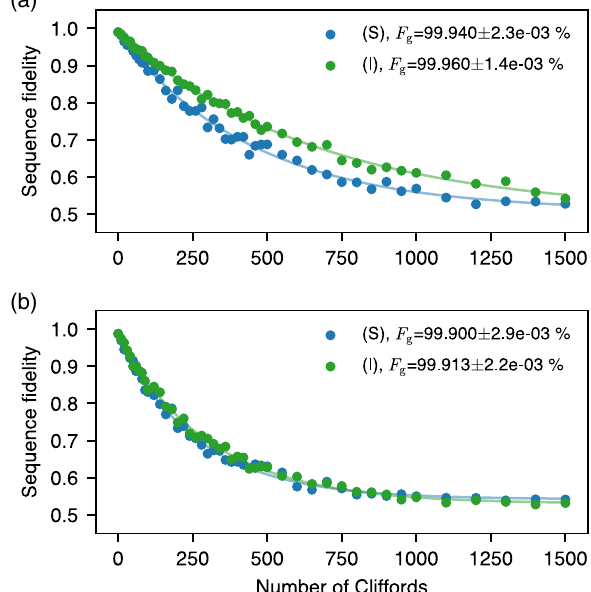
FIG. 23. Experimental results of single-qubit randomized benchmarking, when QB1 and QB2 are detuned by 150 MHz. (a) Single-qubit RB measurement data for QB1. (b) Single-qubit RB measurement data for QB2. “ S ” denotes the simultaneous application of single-qubit Cliffords, and “ I ” denotes the isolated application of single-qubit Cliffords. The pulse duration of X - and Y -rotation gates is 30 ns. QB1 and QB2 are biased at 4.16 and 4.00 GHz, respectively. The gate fidelities are degraded, when measured simultaneously, possibly due to microwave cross talk. The data are averaged over 20 random sequences for each sequence length.